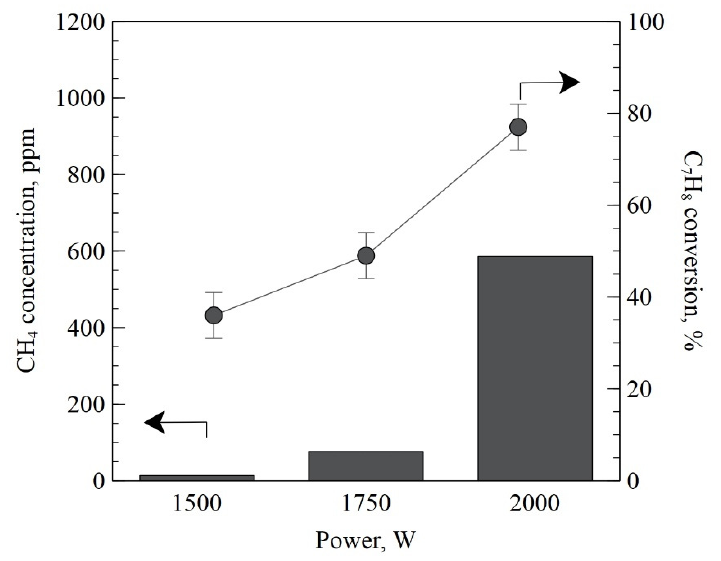
Figure 1. Methane formation and toluene conversion from the molar fraction of hydrogen in inlet gas and the discharge power. Initial toluene concentration 2000 ppm, catalyst Ni/(CaO ‐ Al 2 O 3 ), series B.